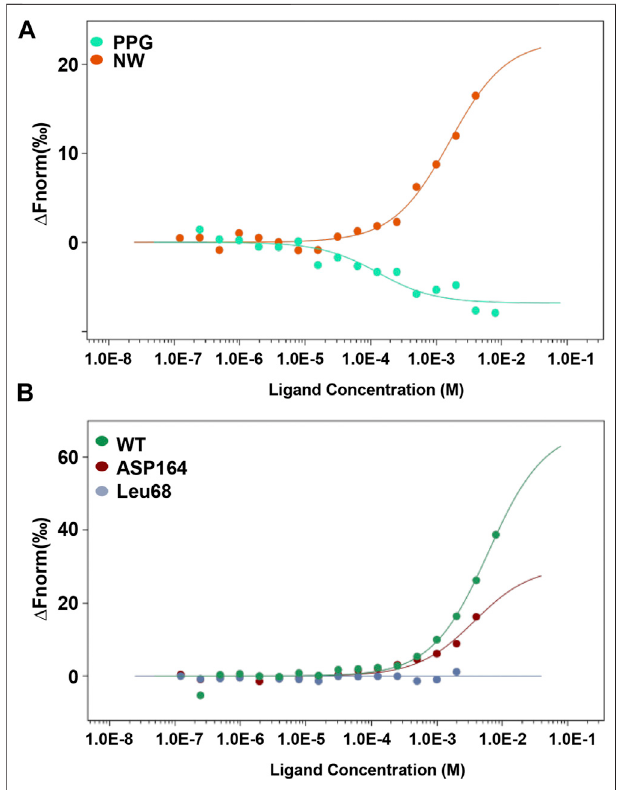
FIGURE2| NWbindingtoCSE.KineticsofNWbindingtoCSEassayed by microscale thermophoresis (MST) (A) . CSE inhibitor PPG, as a positive control. Binding kinetics of NW with CSE mutation (Leu68 site and Asp164 site) (B)